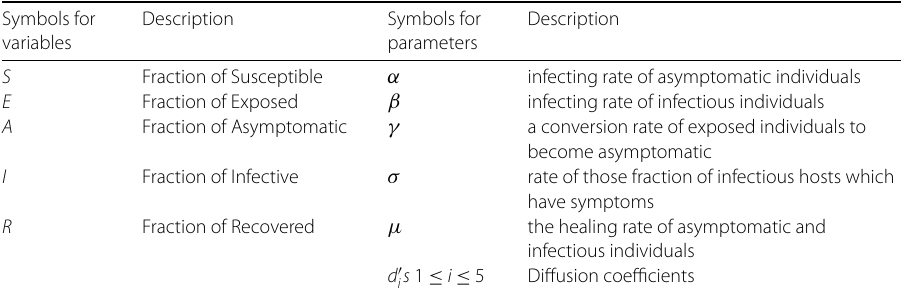
Table 1 Table of the physical meanings of the parameters used in the Diffusive COVID-19 Epidemic model investigated in this work Symbols for Description Symbols for Description variables parameters